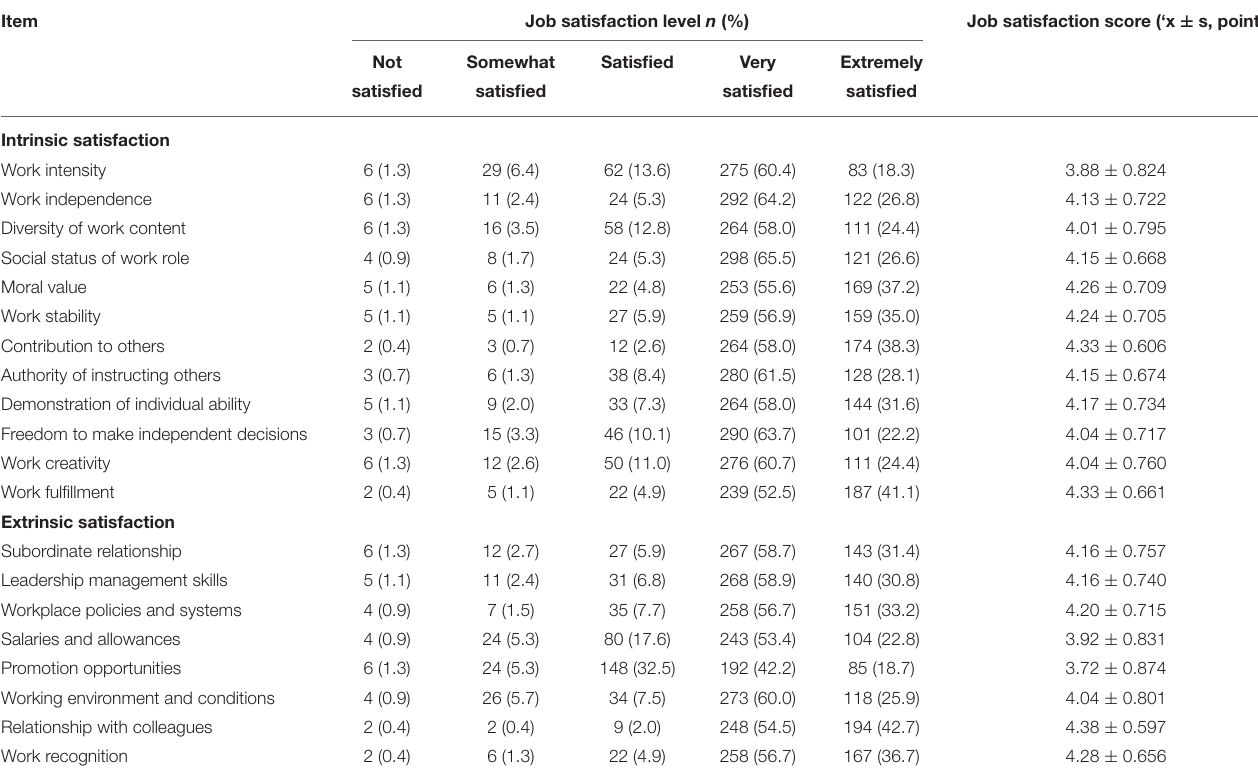
TABLE 2 | Job satisfaction of frontline medical